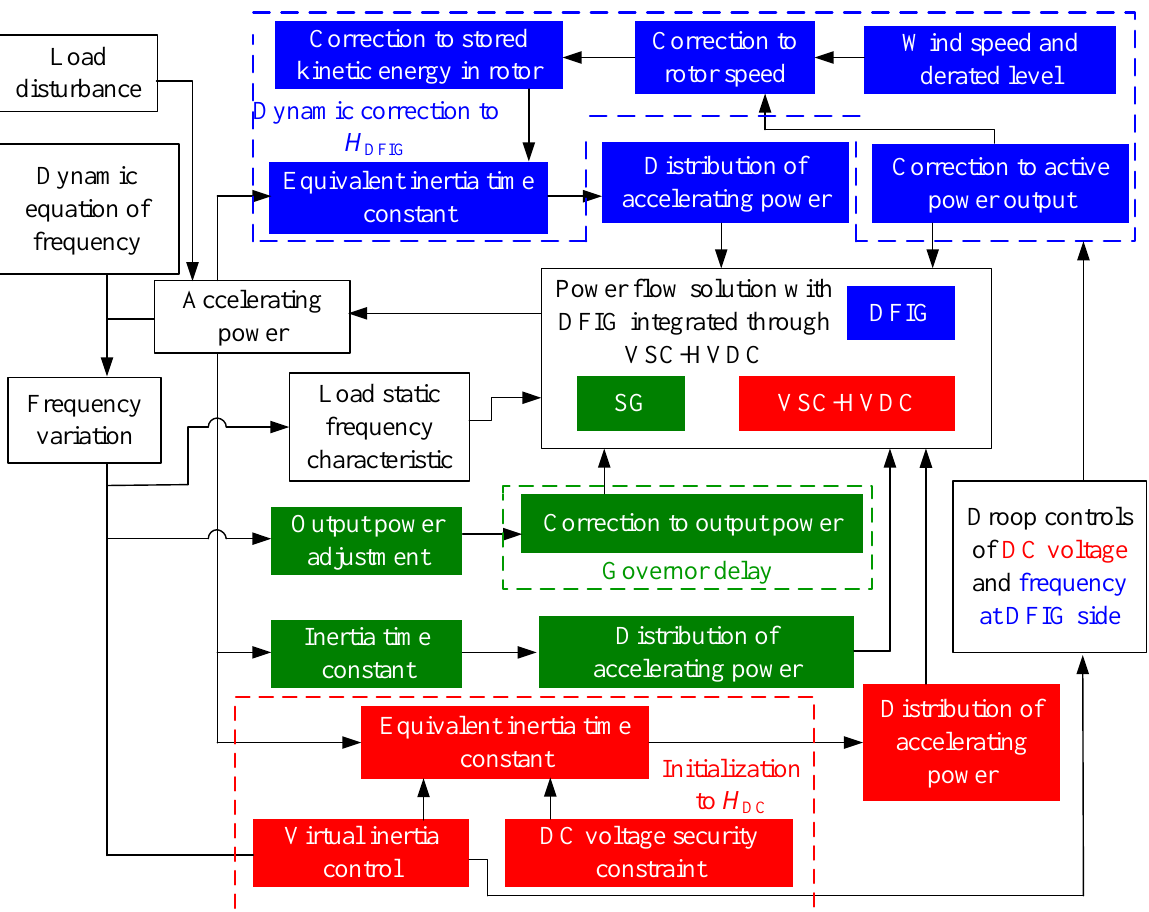
Figure 5. Improved DPF model with DFIG integrated through VSC-HVDC.